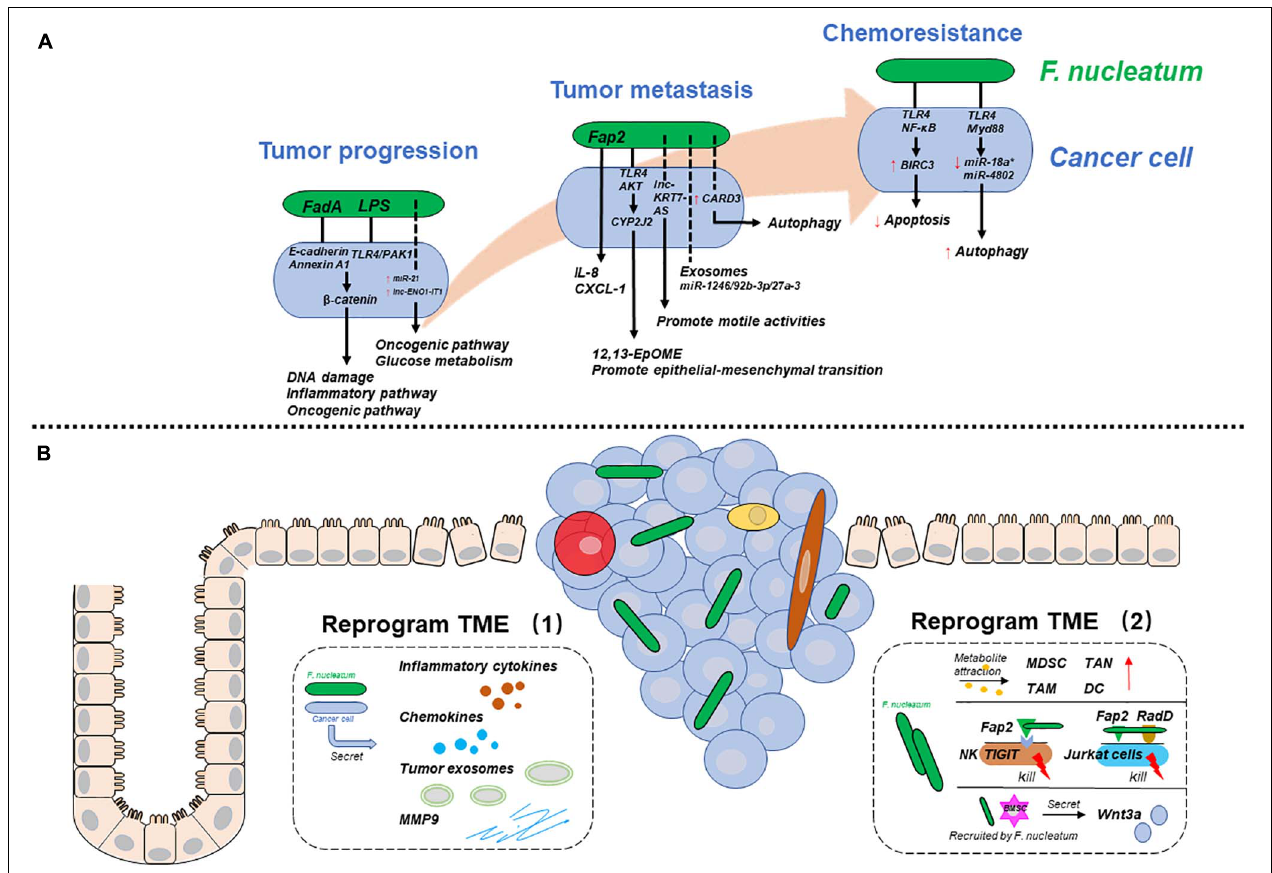
FIGURE 1 | The mechanisms by which F. nucleatum is involved in various CRC stages. (A) F. nucleatum reprograms cancer cells during tumor progression, metastasis, and chemoresistance. (B) F. nucleatum reprograms the tumor microenvironment (TME) by interacting with cancer cells (left), immune cells and others (right). Solid lines represent proven mechanisms, and dotted lines represent unclear